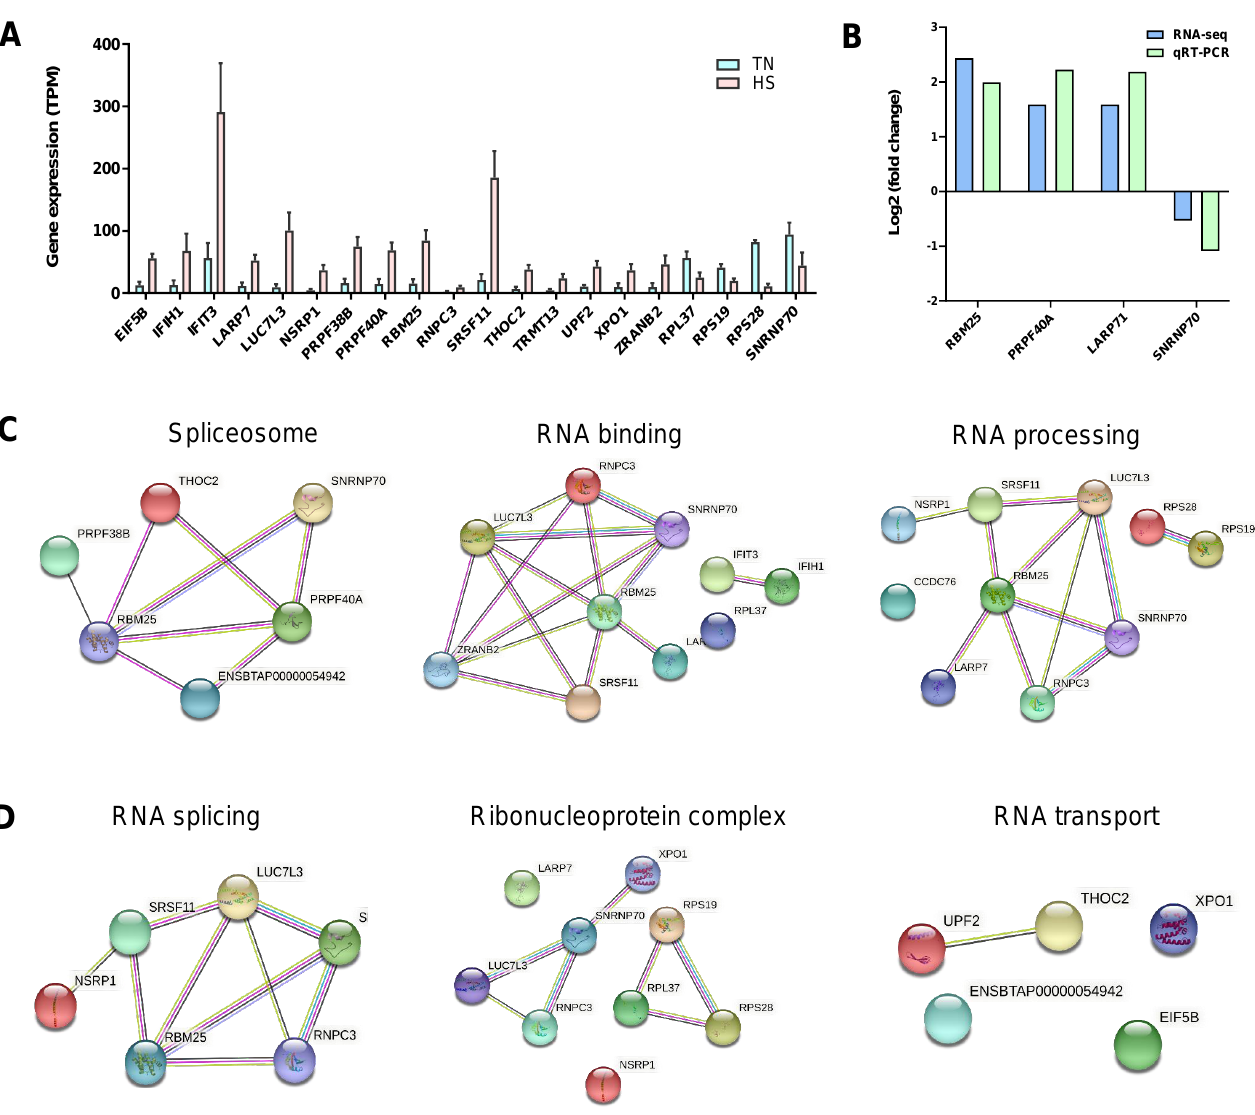
Figure 6. The expression patterns and protein-protein interactions of 20 genes involved in heat stress regulation. ( A ) Expression levels of 20 genes generated from RNA-seq. The values for RPL37 , RPS19 , and RPS28 present as 100 times smaller. TPM: transcripts per million. ( B ) Comparative analysis of the expression levels of five selected genes between RNA-seq and real-time quantitative PCR (qRT- PCR). ( C ) Protein-protein interaction of genes involved in the spliceosome, RNA binding, and RNA processing. ( D ) Protein-protein interaction of genes involved in RNA splicing, ribonucleoprotein complex, and RNA